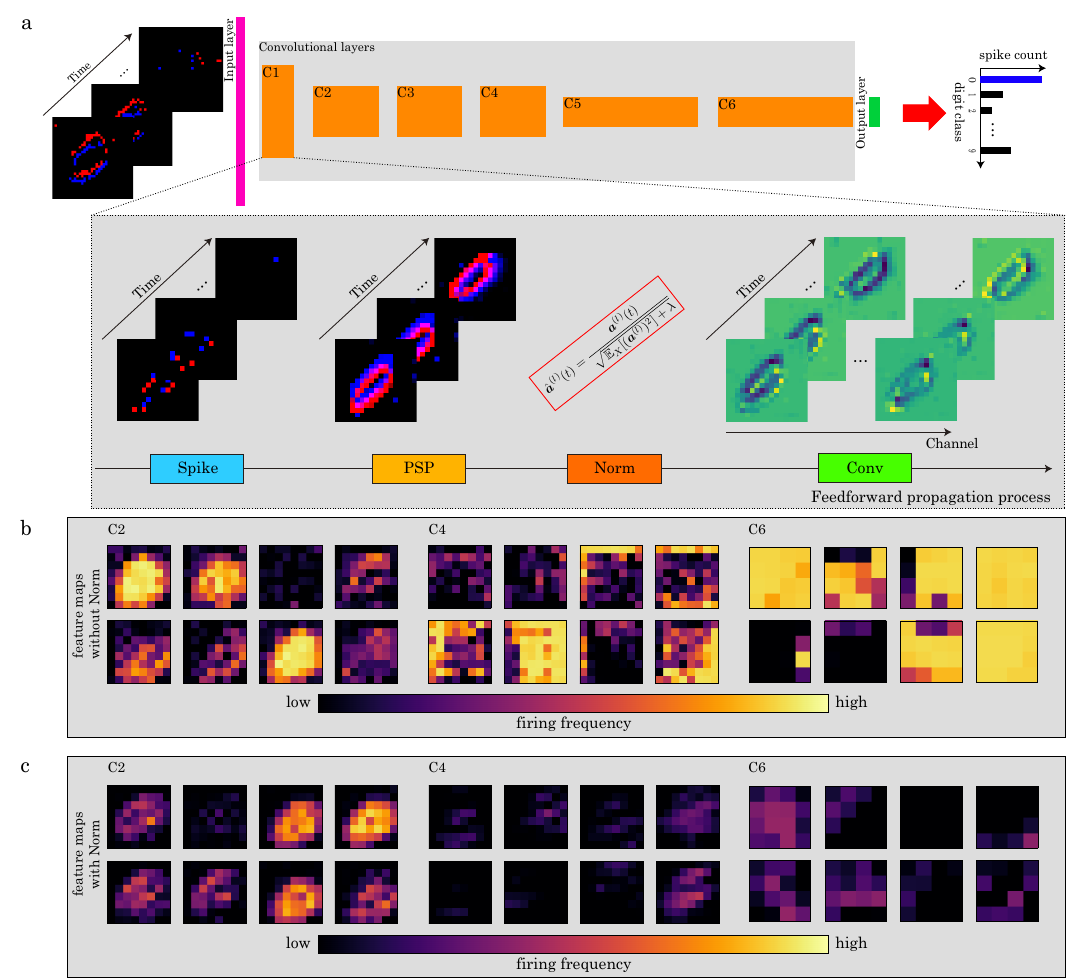
Figure 6. ( a ) Overview of the forward propagation phase using postsynaptic potential (PSP) nor- malization on the N-MNIST dataset. ( b ) Example of feature maps, which are integrated along the time axis, without PSP normalization. ( c ) As in ( b ) but for feature maps with it. PSP normalization controls the activity of the network and prevents the over-firing of the